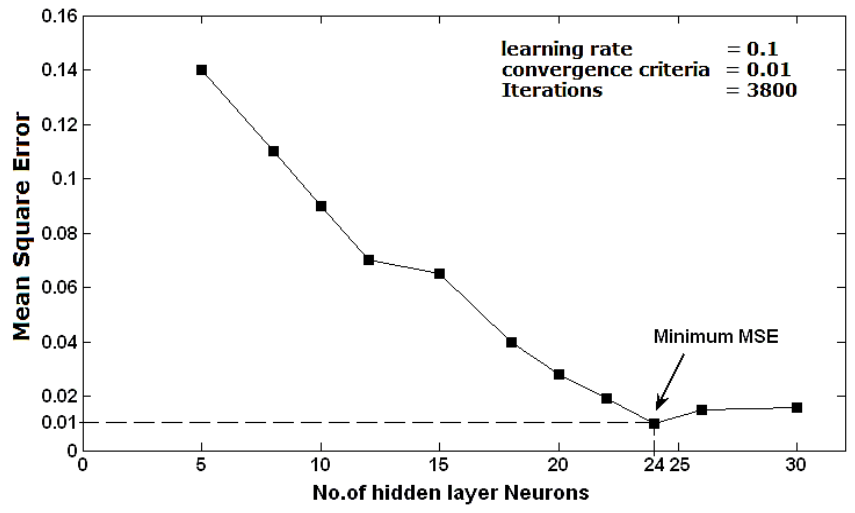
Figure 24. Evaluation of the mean square error of the neural network at different numbers of hidden layer neurons.